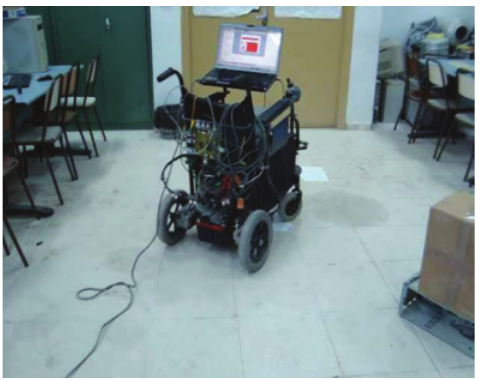
Figure 13: Navigation of Wheelchair with Obstacle Avoidance.